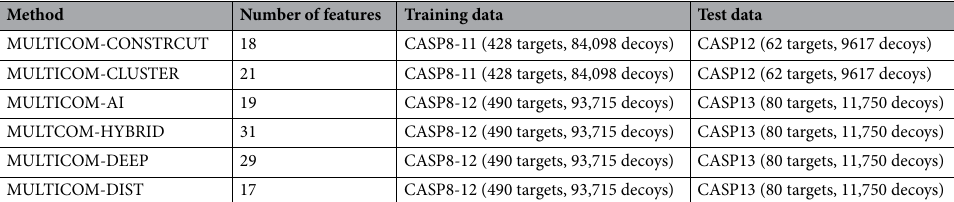
Table 1. The number of features and training/test data used by MULTICOM EMA predictors. The details of the features can be found in Table 2. The structural models of CASP8-13 were used in training and test. MULTCIOM-AI used 20% of training targets as validation dataset, while the other five predictors used 10% of training targets as validation